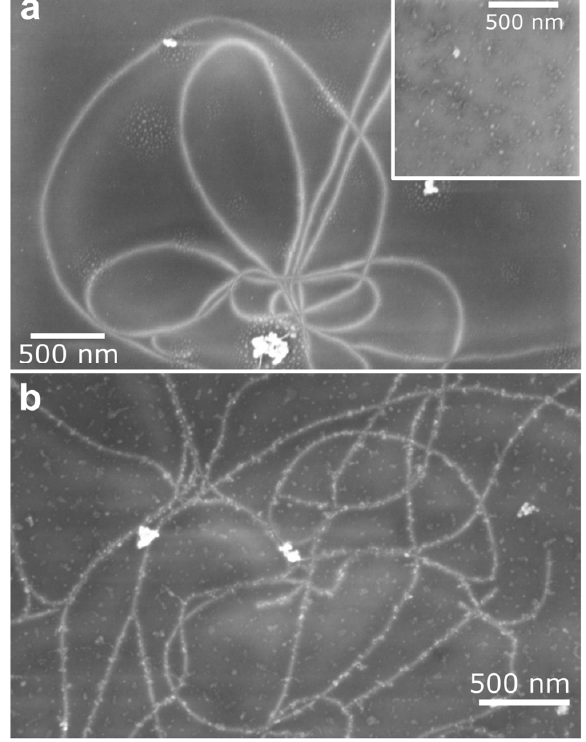
Figure 8. SEM images of CVD-grown nanotubes (a) after passivation and oxidation and (b) after functionalization with gold nanoparticles. Very bright white aggregated spots indicate catalyst particles. The inset shows the SiO 2 surface after passivation and oxidation.